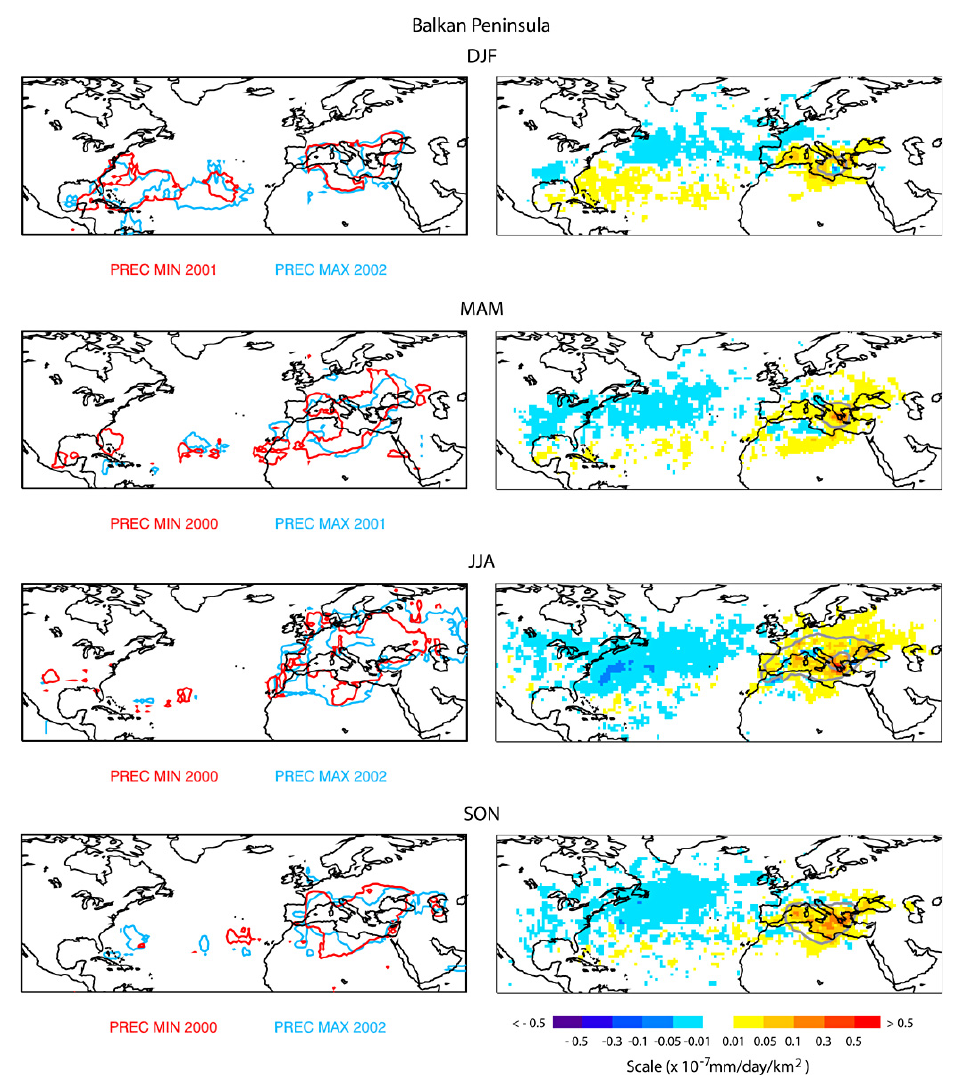
Fig. 5. As Fig. 2, but for the Balkan Peninsula (BP), considering its equivalent area as 353643km 2